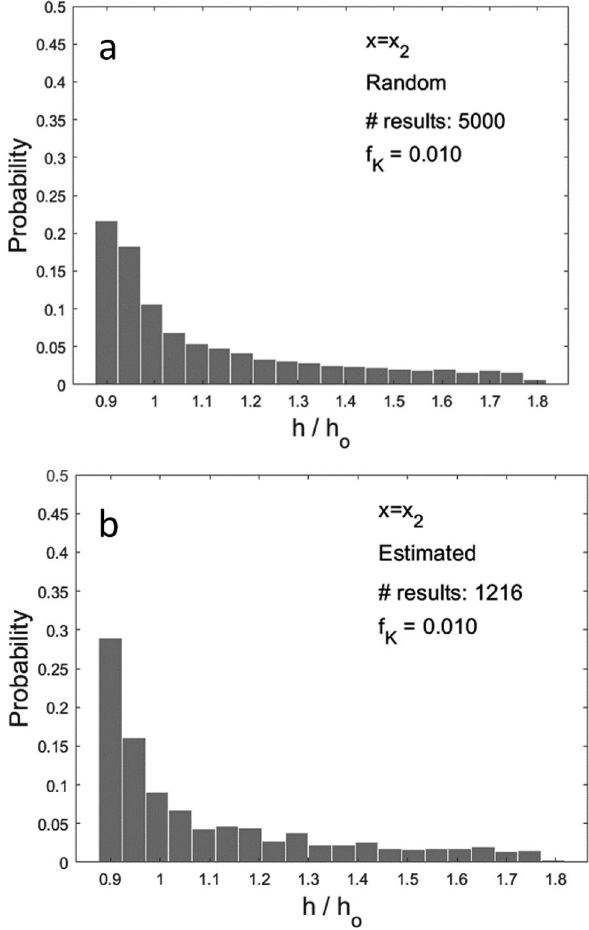
Fig. 10 Uncertainty of predicted piezometric head at position x 2 = 0.8 L using a randomly generated sets of parameters K 1 and K 2 and b after parameter estimation. Normalized simulated head expressed as function of the head value assigned to right